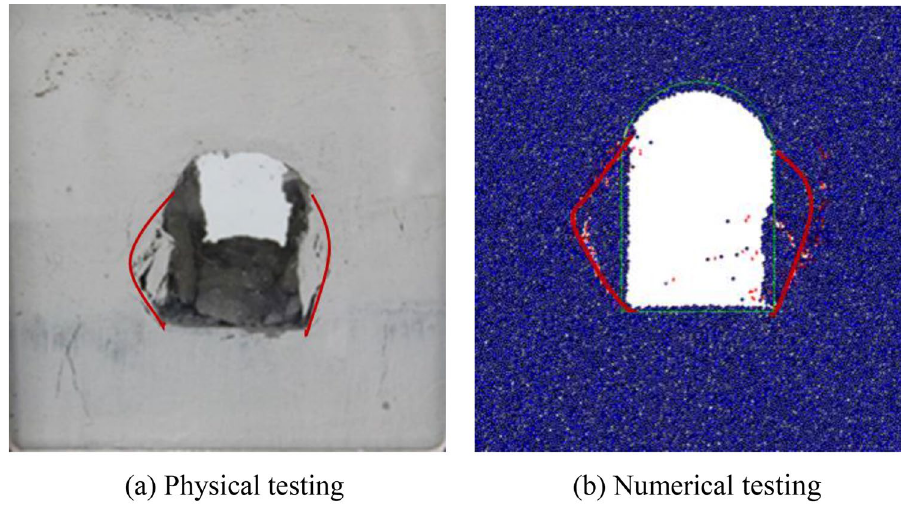
Figure 24. Comparison of failure planes of the physical and numerical excavation unloading testing.